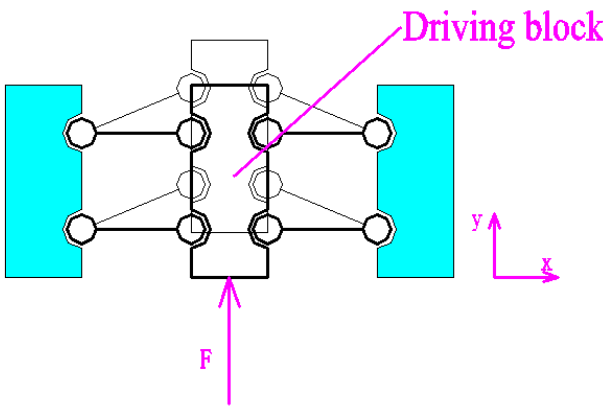
Figure 2. 2D motion platform structure composition.